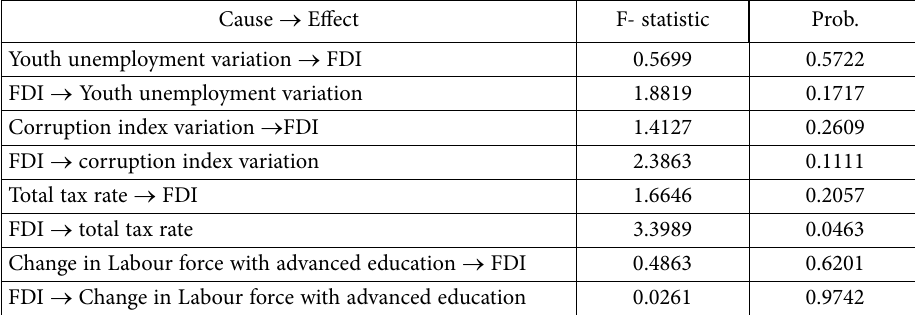
Table 9. Granger causality test for FDI and other variables in V4 countries (2005–2016) (source: own results)